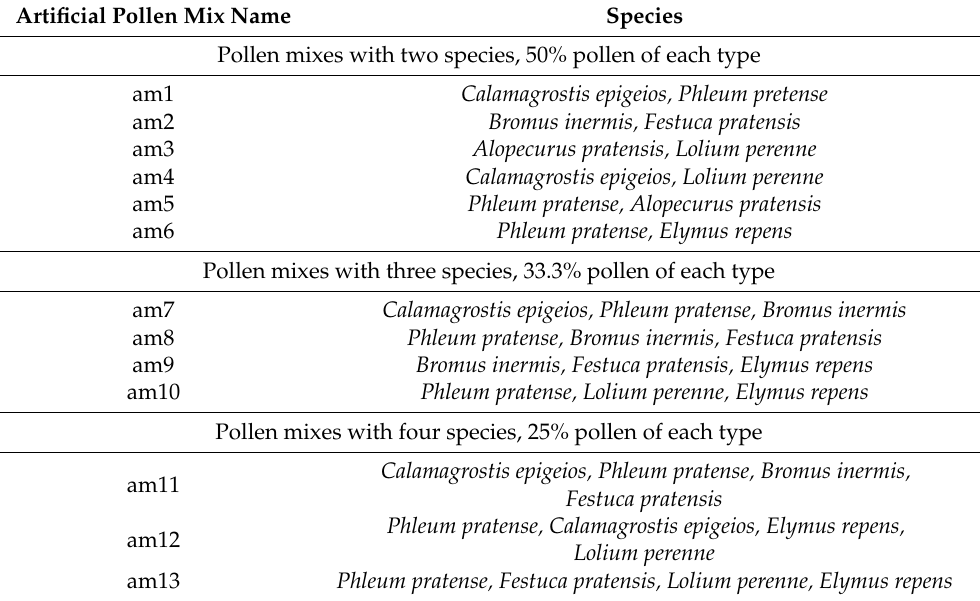
Table 1. Pollen artificial mixes’